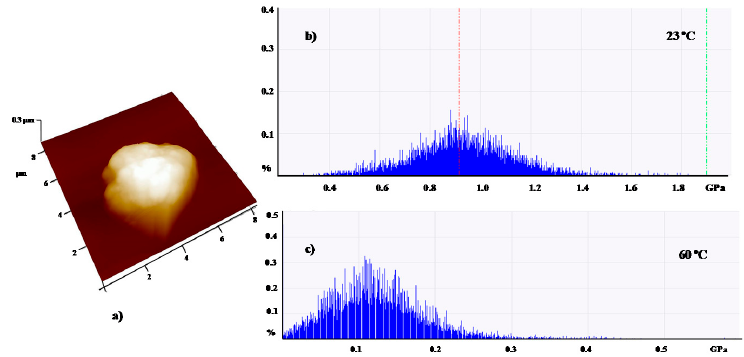
Figure 7. Results for PS and tetracosane for 1:1 encapsulation mass ratio: ( a ) 3D image tested; ( b ) Young’s modulus results at 23 °C; ( c ) Young’s modulus results at 60 °C.